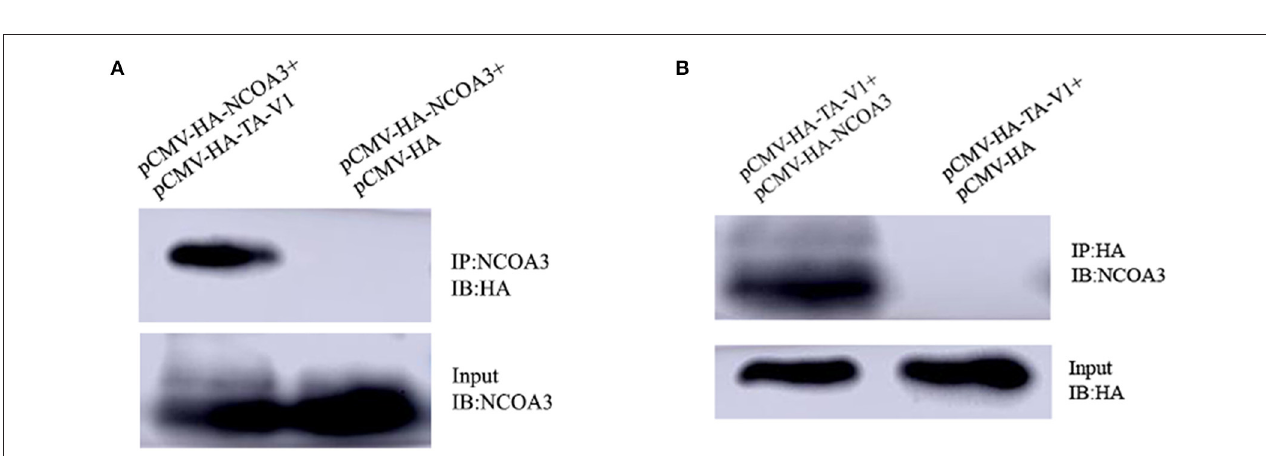
FIGURE 11 | The effects of co-transfection of TA-V1 and NCOA3 on EdU staining, cell cycle and expression level of CyclinD1. (A) The percentage of EdU positive cells after co-transfection of TA-V1 and NCOA3 . (B) The effects on cell cycle after co-transfection of TA-V1 and NCOA3 . (C) The effects of co-transfection of TA-V1 and NCOA3 on the expression level of CyclinD1 . The NS means no significant. ** p < 0.01.